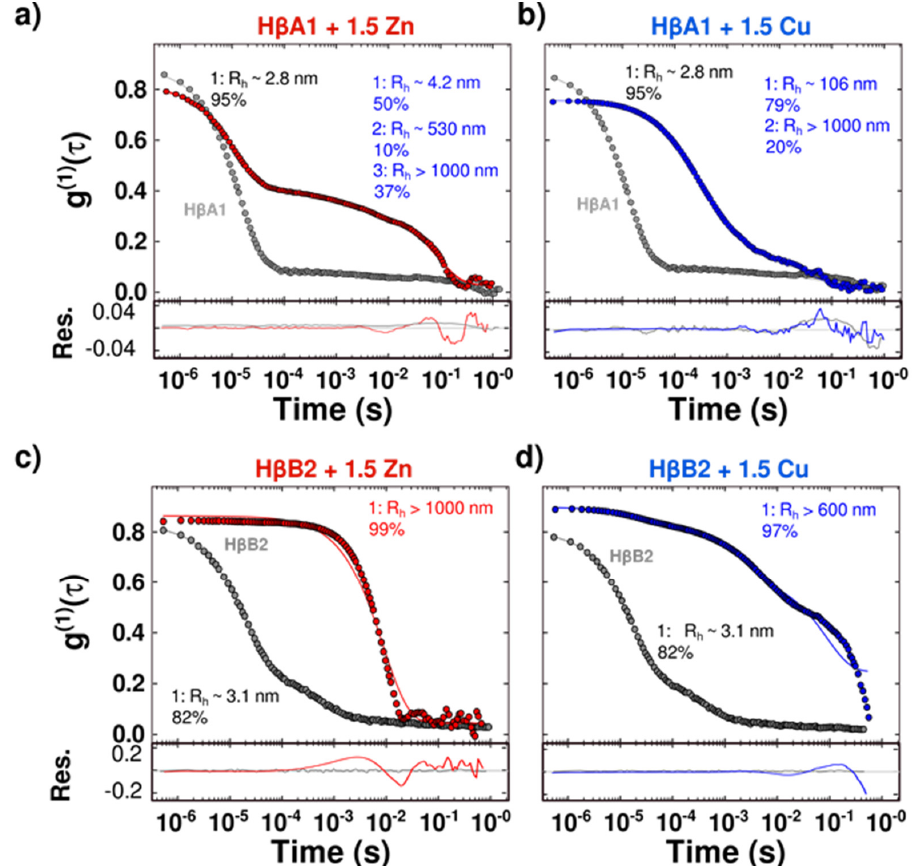
Figure 3. Protein oligomerization induced by metal-binding. ( a ) H β A1 correlation coefficient in the absence (gray) and presence of 1.5 equivalents of Zn(II) (red). ( b ) H β A1 correlation coefficient in the absence (gray) and presence of 1.5 equivalents of Cu(II) (blue). ( c ) H β B2 correlation coefficient in the absence (gray) and presence of 1.5 equivalents of Zn(II) (red). ( d ) H β B2 correlation coefficient in the absence (gray) and presence of 1.5 equivalents of Cu(II) (blue). Measurements with metal ions yielded a shift to the right indicating an increase in size due to oligomerization. Calculated R H are shown. (Replica spectra are shown in Figure